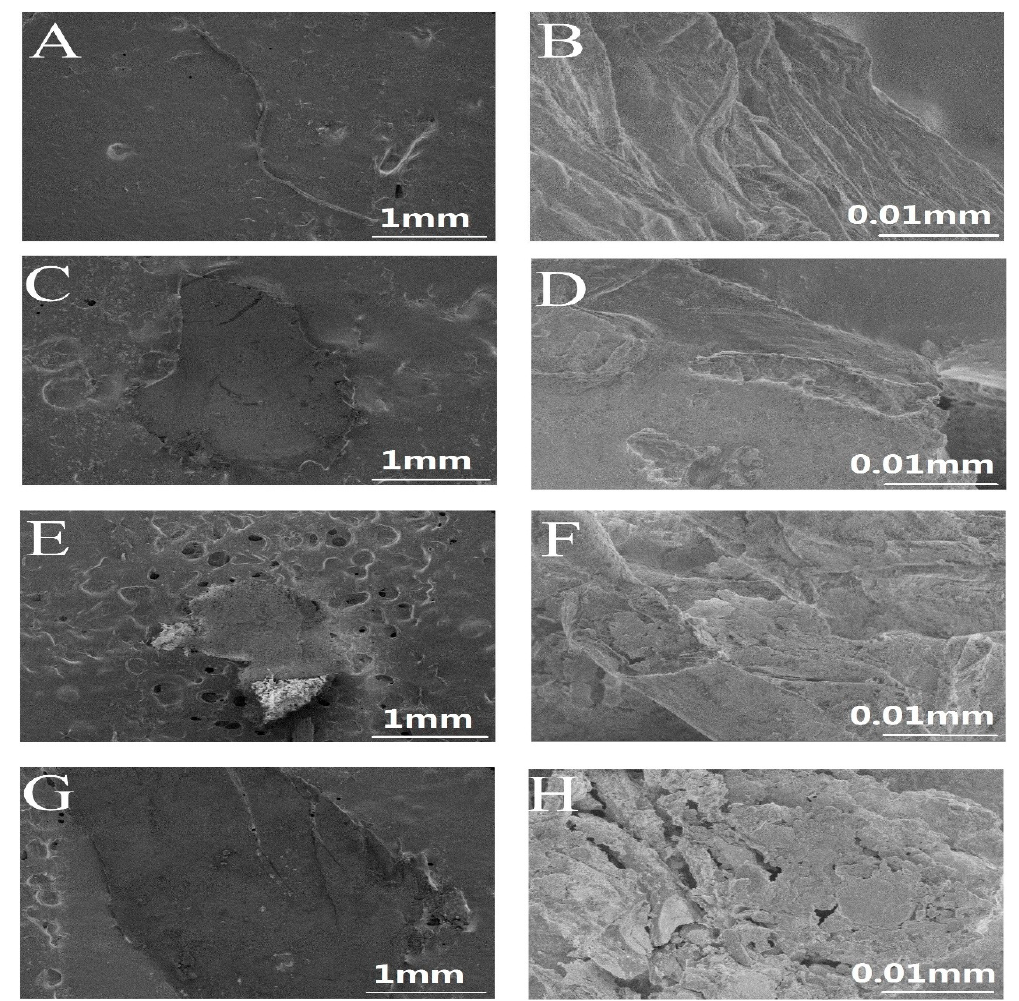
Figure 4. SEM images of microplastics: ( a , b ) line, ( c , d ) fragment, ( e , f ) foam, ( g , h ) film.